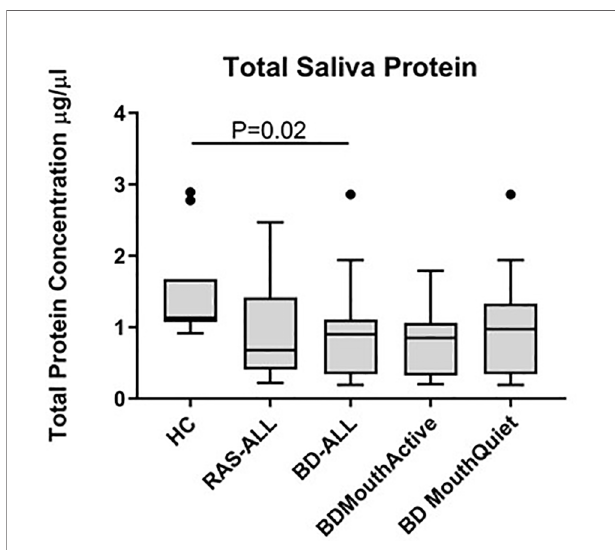
FIGURE 3 | Total protein concentrations in saliva of healthy controls (HC), Behc ̧ et ’ s Disease (BD) and recurrent aphthous stomatitis (RAS) patients. The Tukey box plots show levels in BD-ALL (N=20), RAS-ALL (N=7) and HC (N=10). The BD patients were further grouped into patients with oral ulceration, BD Mouth Active (N=9), and patients with no oral ulceration, BD Mouth Quiet (N=11). Mann-Whitney U test, signi fi cance based on two tailed 95% con fi dence interval (CI). Exact P values are